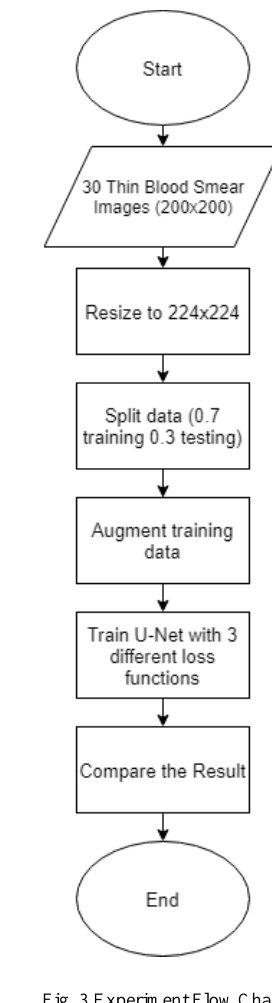
Fig. 3 Experiment Flow